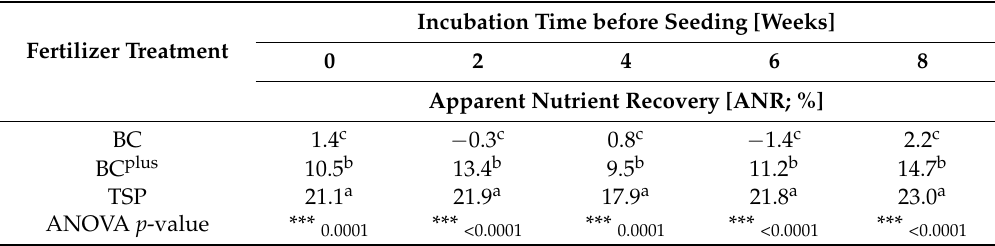
Table 3. Analysis of variance (ANOVA) 1 and Tukey-Kramer HSD t -test 2 on apparent nutrient recovery (ANR; %) in dependence of fertilizer type and incubation time before seeding.